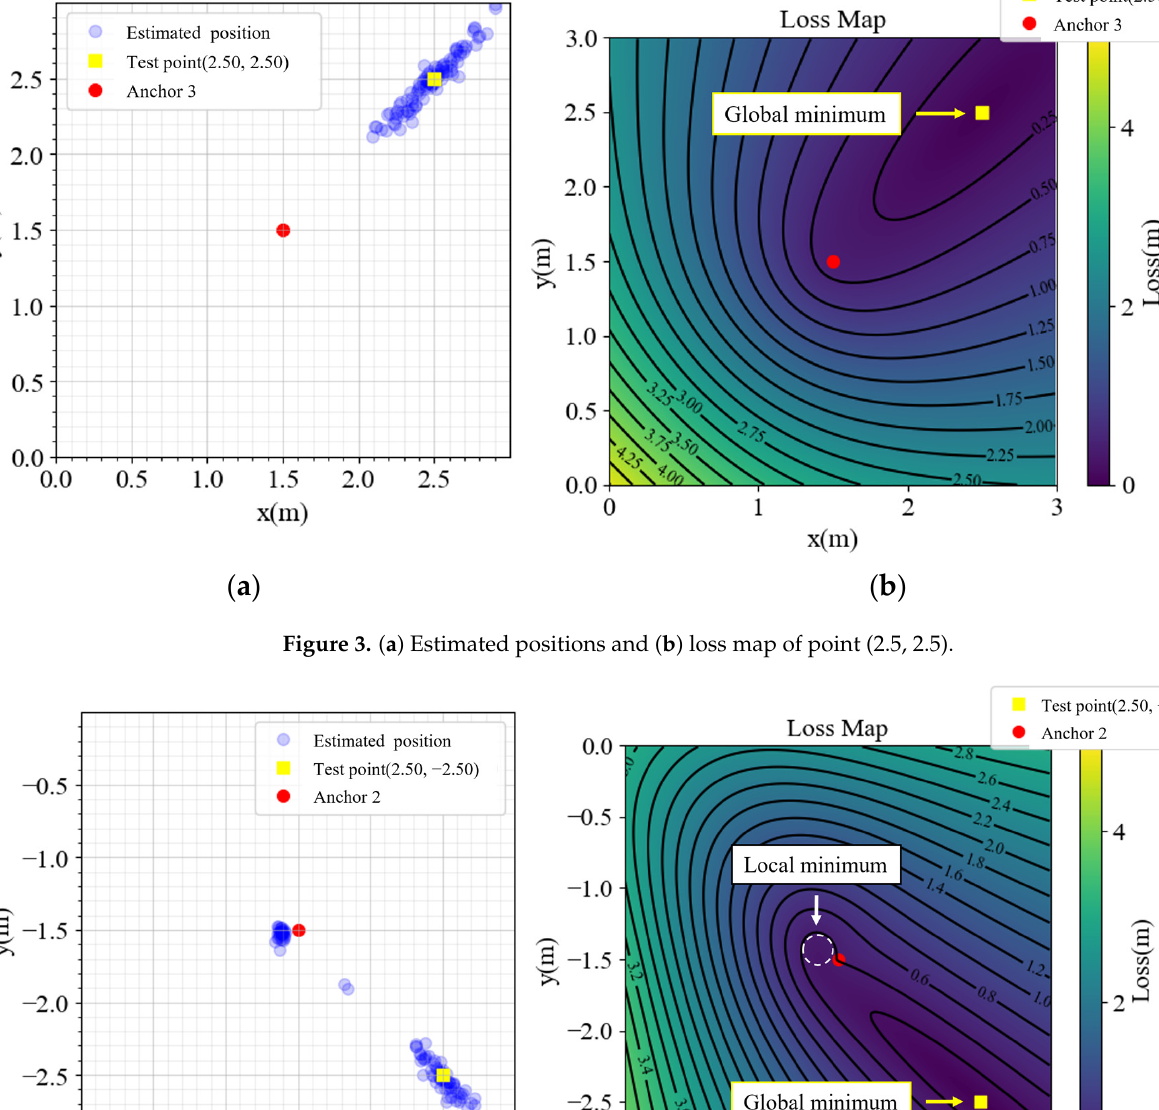
Figure 4. ( a ) Estimated positions and ( b ) loss map of point (2.5, − 2.5).